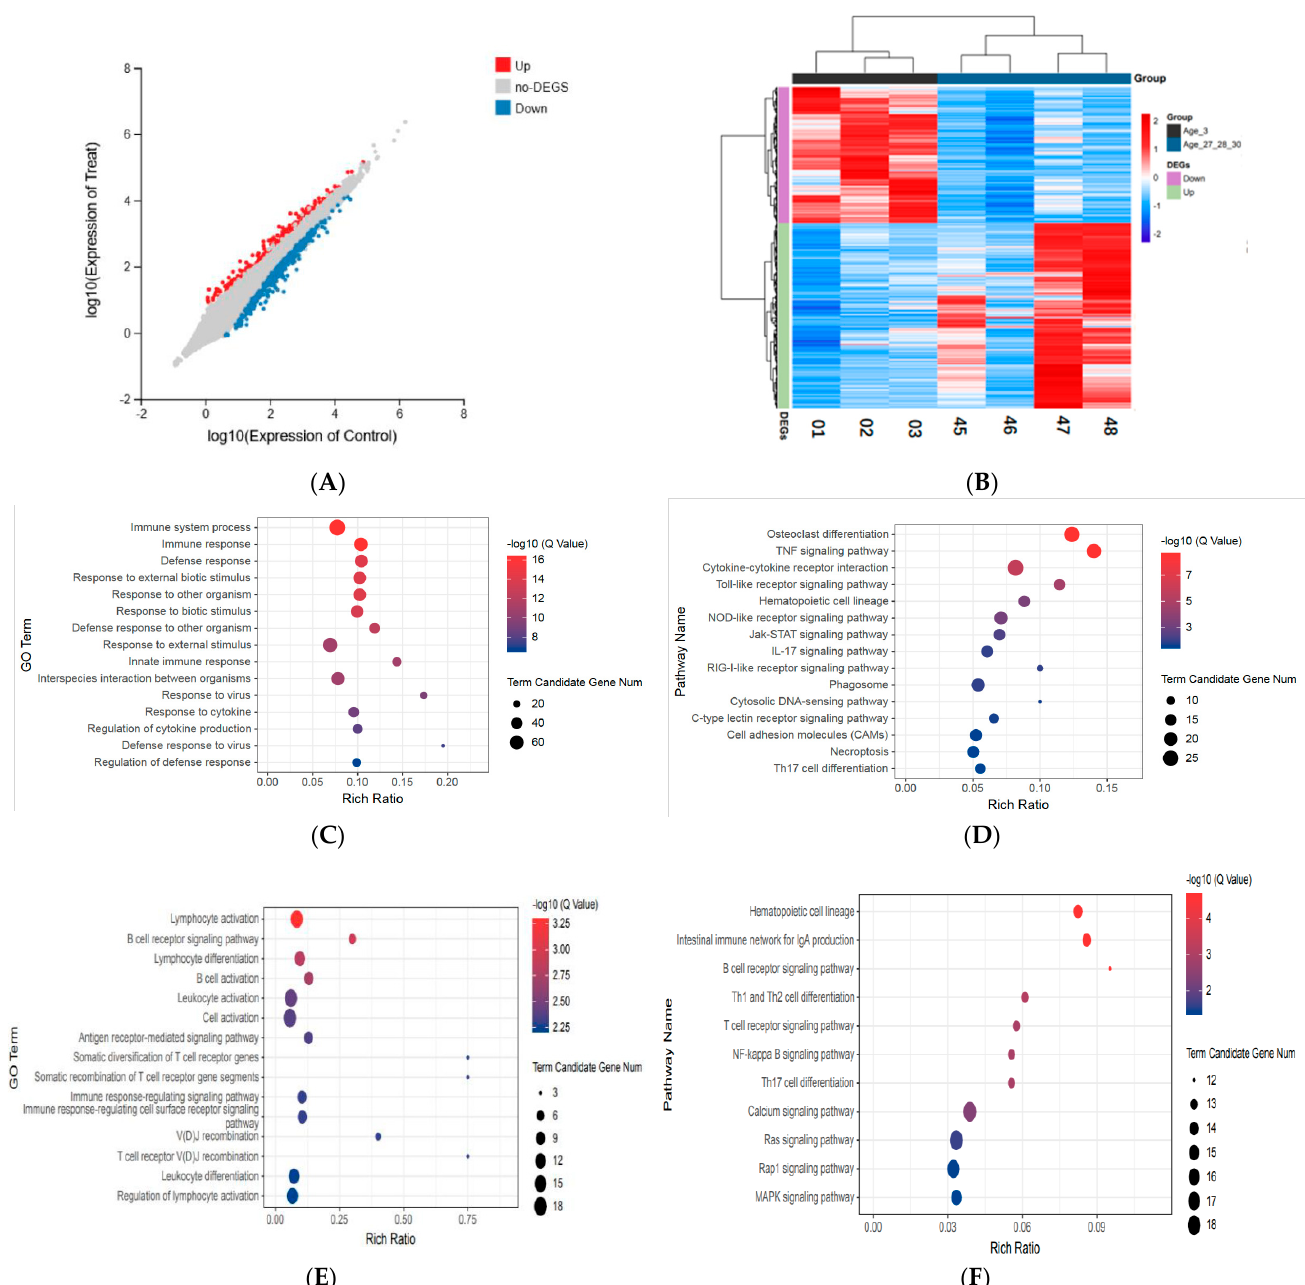
Figure 1. The number of differentially expressed genes of giant pandas in different age groups com- pared to three-year-old groups.